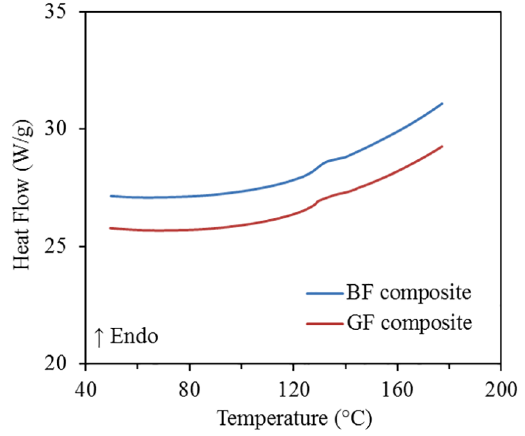
Figure 2. DSC curves for BF and GF